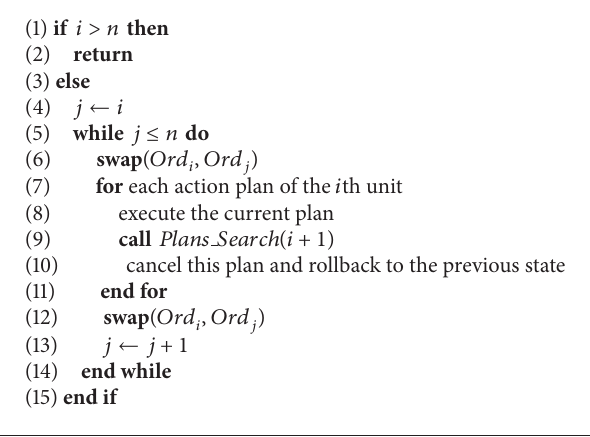
Algorithm 5: Recursive enumeration algorithm: 𝑃𝑙𝑎𝑛𝑠 𝑆𝑒𝑎𝑟𝑐ℎ(𝑖) (search action plans from 𝑖 th to the last